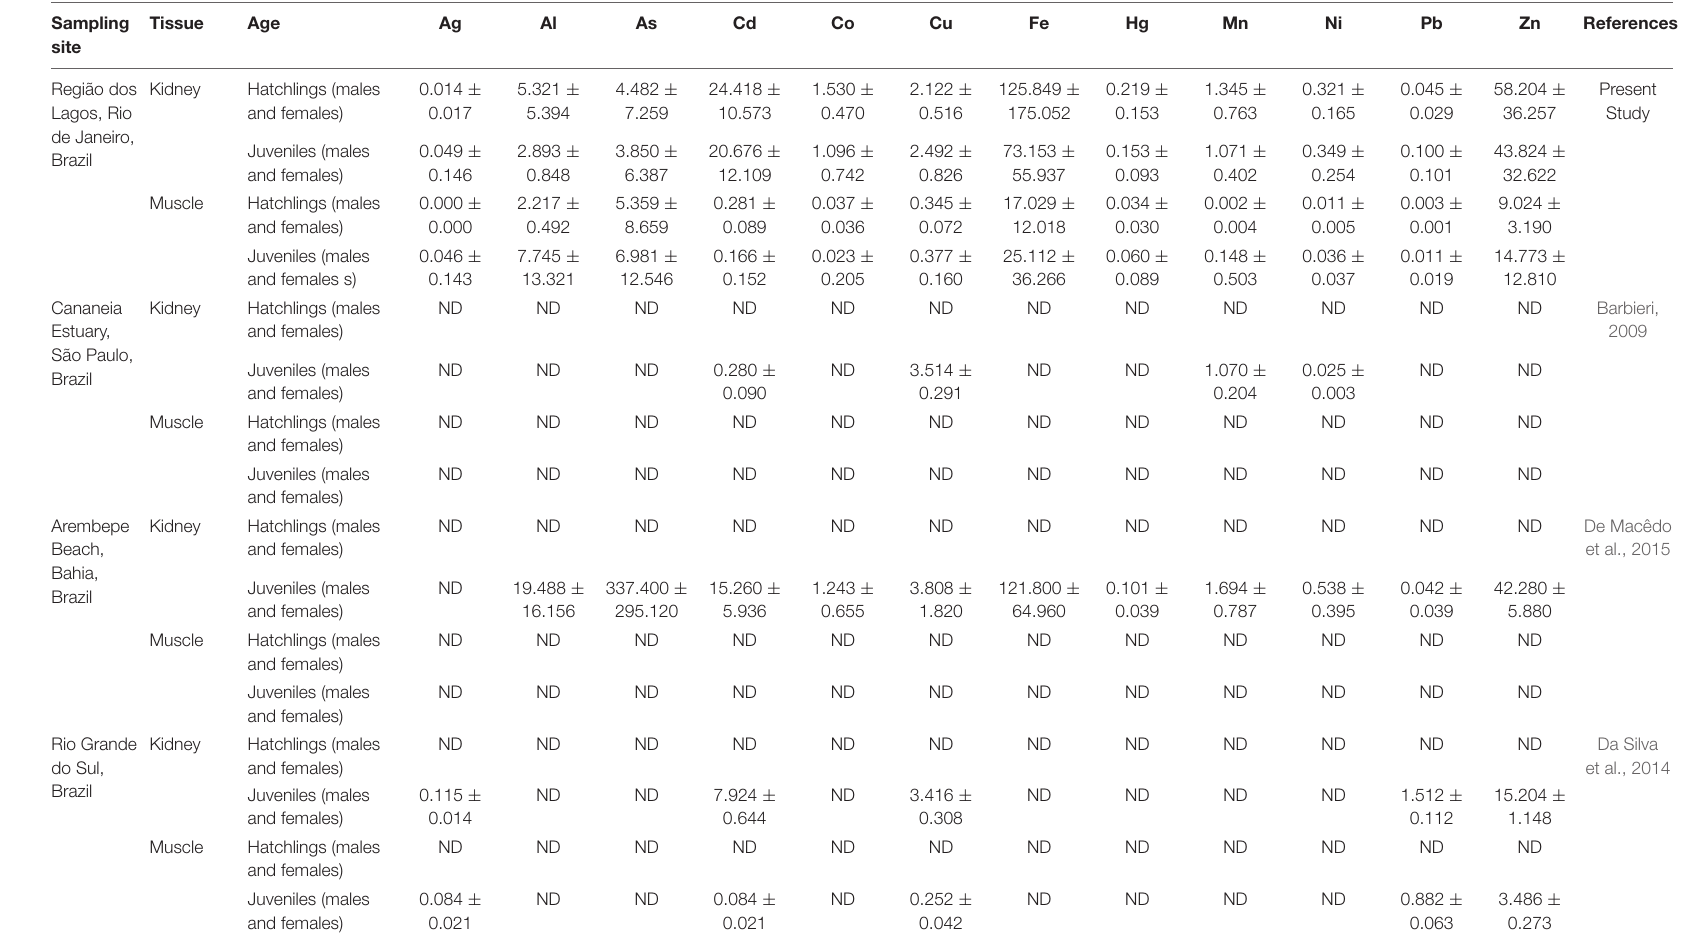
TABLE 5 | Literature comparisons of metal concentrations (mg kg − 1 ) in green turtle ( Chelonia mydas ) tissues conducted in other areas throughout the Brazilian coast. Sampling